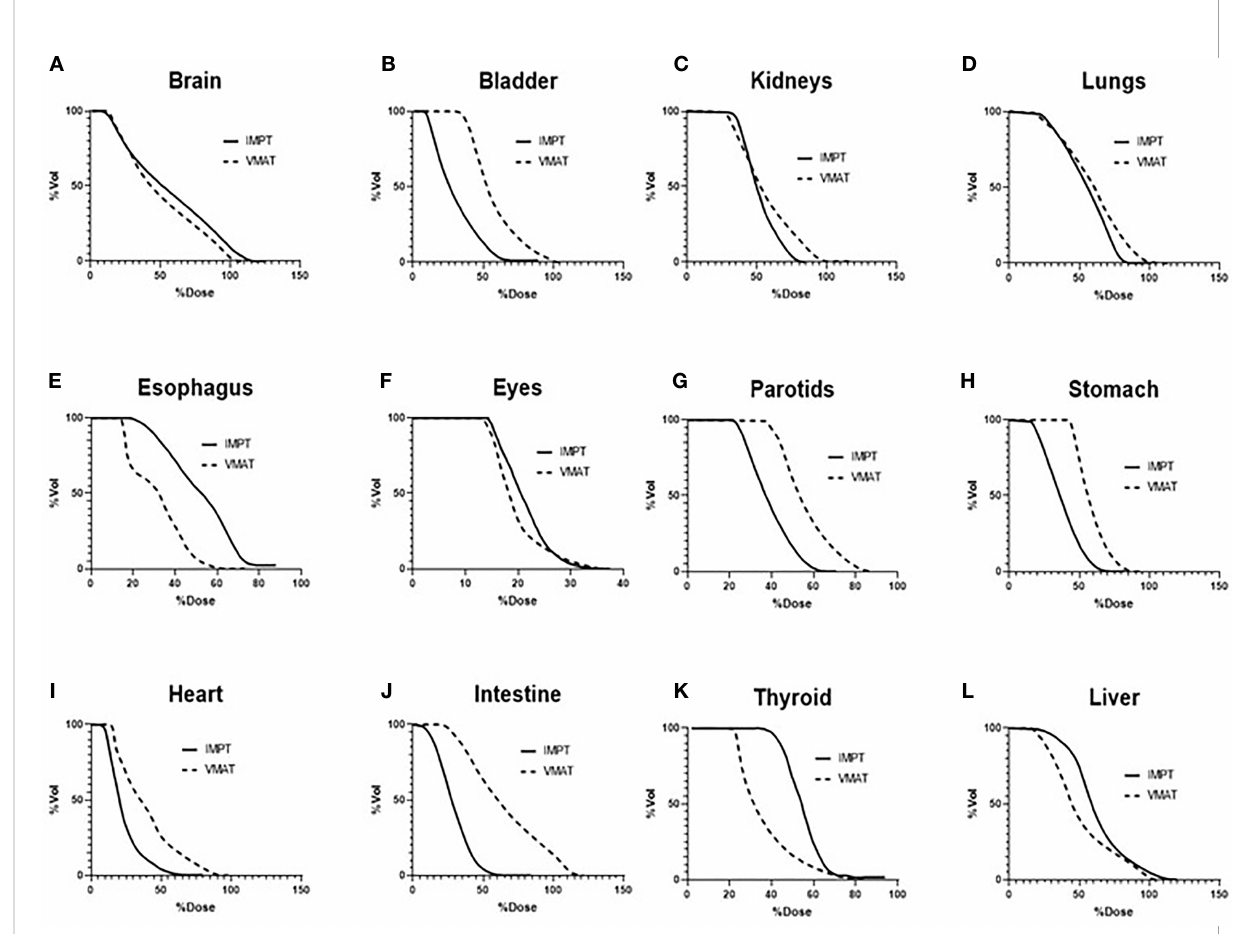
FIGURE 5 Average DVHs of the OARs comparing VMAT to IMPT plans: (A) brain, (B) bladder, (C) kidneys, (D) lungs, (E) esophagus, (F) eyes, (G) parotids, (H) stomach, (I) heart, (J) intestine, (K) thyroid, and (L) liver. DVHs, dose – volume histograms; OARs, organs at risk; VMAT, volumetric modulated arc therapy; IMPT, intensity-modulated spot-scanning proton